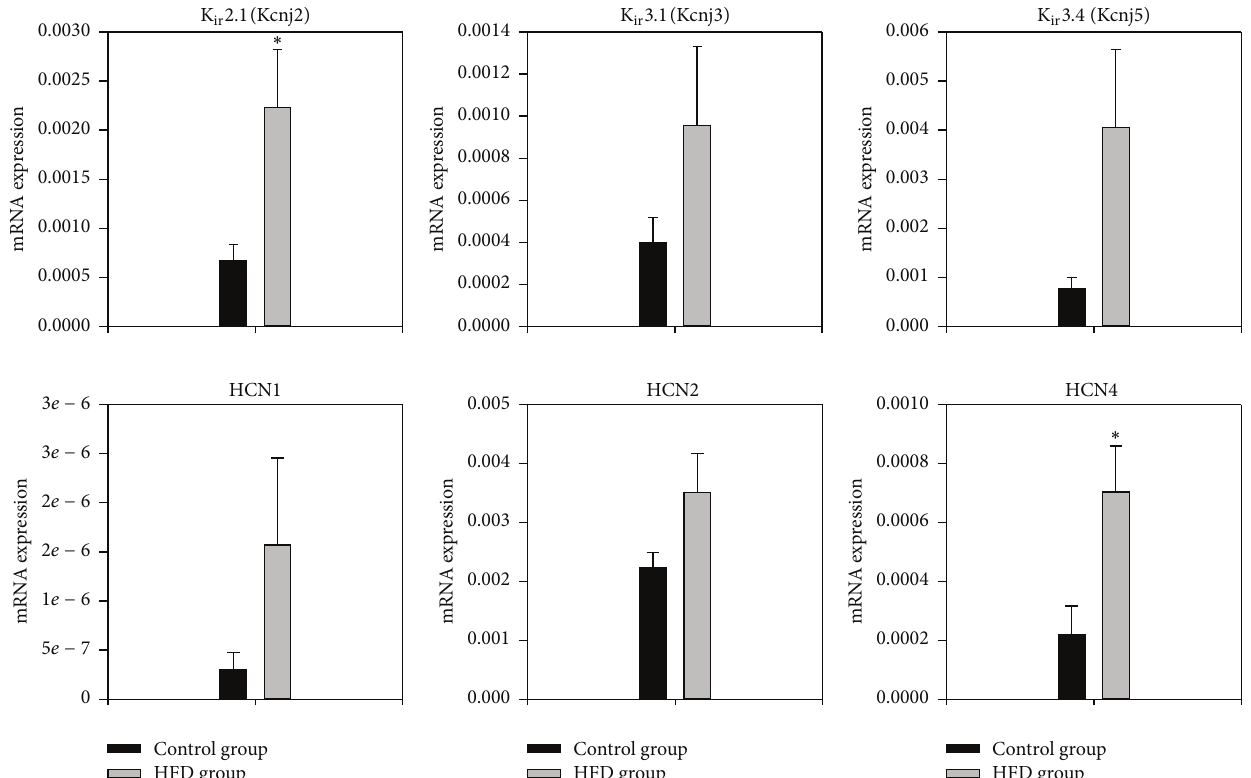
Figure 2: Normalised to 18-s expression of mRNA for major ion channels active largely during diastole in the left ventricle of the control and obesity groups in arbitrary units referenced to the housekeeper gene 18-s. Means ± SEM shown ( 𝑛 = 8 /group). ∗ Significantly different from the control group ( 𝑃 < 0.05